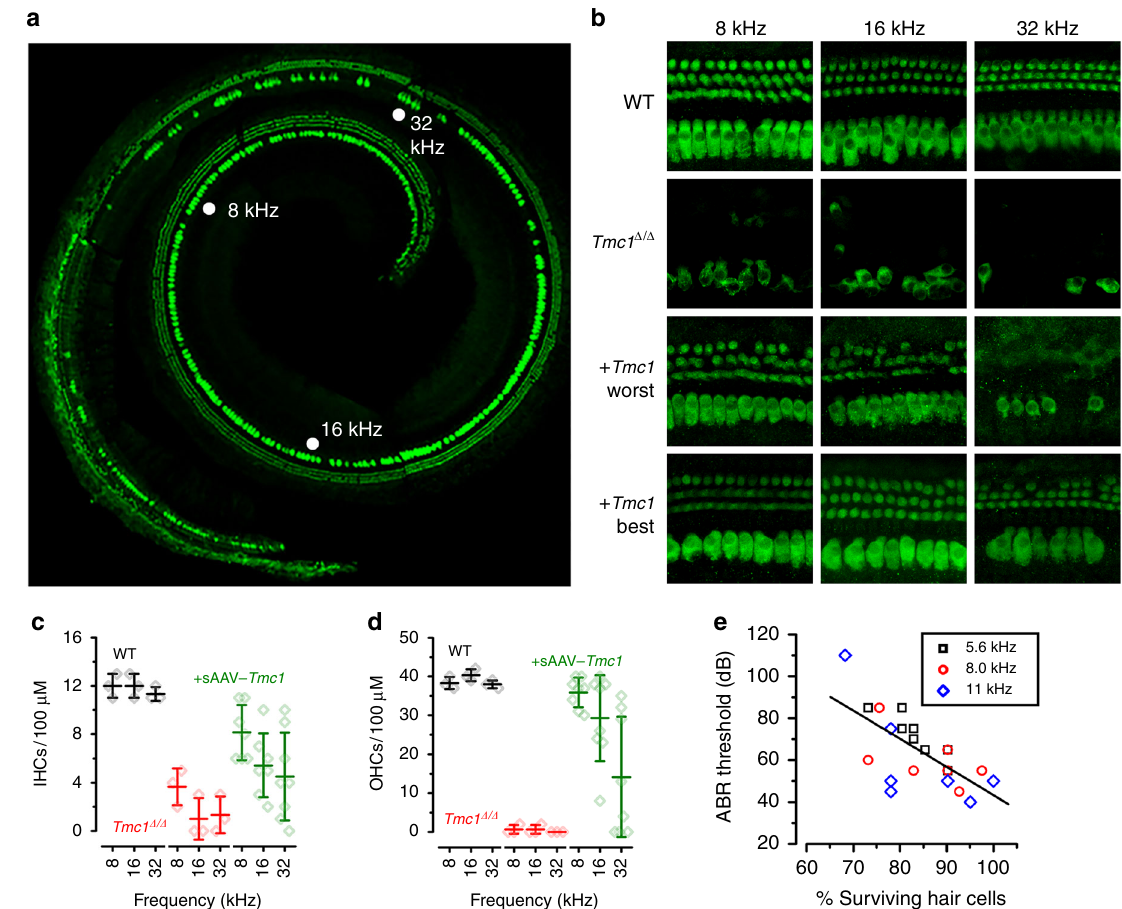
Fig. 3 sAAV- Tmc1 promotes survival of IHCs and OHCs in Tmc1 Δ / Δ mice. a Composite of fi ve images from a whole cochlea harvested at 12 weeks old from a Tmc1 Δ / Δ mouse injected with sAAV- Tmc1 on P1 reconstructed from microdissected tissue. The tissue was stained for Myo7a (green). b Tonotopically mapped cochlear sections (image width = 100 µ m) at 8, 16, and 32 kHz regions for WT (top), Tmc1 Δ / Δ (second), and Tmc1 Δ / Δ -injected with sAAV- Tmc1 on P1 with the worst (third) and best (bottom) ABR performances as indicated in Fig. 2. c , d The number of surviving IHCs ( c ) and OHCs ( d ) in sections indicated in b from 3 WT mice, 3 uninjected Tmc1 Δ / Δ , and eight Tmc1 Δ / Δ mice injected with sAAV- Tmc1 on P1 showing mean ± S.D. Number of surviving IHCs in the 8 and 16 kHz was signi fi cantly greater in injected ears than in uninjected Tmc1 Δ / Δ ears at ( t -test: p = 0.015, 0.03, 0.19, respectively). Number of surviving OHCs in the 8 and 16 kHz was signi fi cantly greater in injected ears than in uninjected Tmc1 Δ / Δ ears at ( t -test: p = 1E − 7, 0.002, 0.16, respectively). e The percentage of surviving hair cells at 12 weeks of age was correlated with ABR thresholds measured between 5.6 and 11 kHz from sAAV- Tmc1- injected Tmc1 Δ / Δ mice. The data were fi t with a linear regression with r = − 0.67 and p = 6.2 × 10 -4 ( n = 7 mice; 21